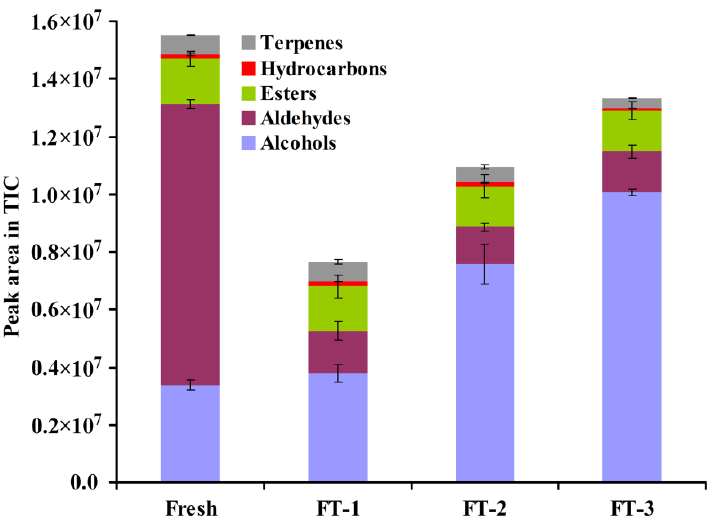
Figure 3. Abundance of peak area in TIC assigned to different class of volatiles for different samples. FT-1, FT-2 and FT-3 represent the sample with FT treatment once, twice and third times.